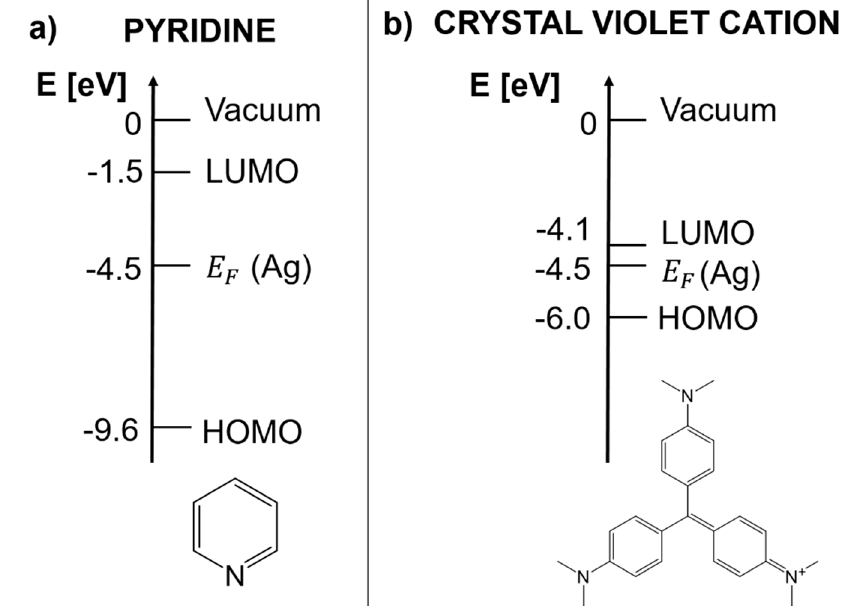
Figure 4. ( a ) Energy diagram for pyridine. The highest occupied molecular orbital (HOMO) energy has been approximated as the ionization energy of pyridine, determined from photoelectron spectroscopy measurements [142]; the energy difference between the lowest unoccupied molecular orbital (LUMO) and the Fermi level has been estimated with inverse photoemission spectroscopy [11]; the Fermi level of silver has been estimated by a photoelectric method [9,137,143]. ( b ) Energy diagram for the crystal violet cation. The HOMO and LUMO energies have been estimated with electrochemical methods [146].